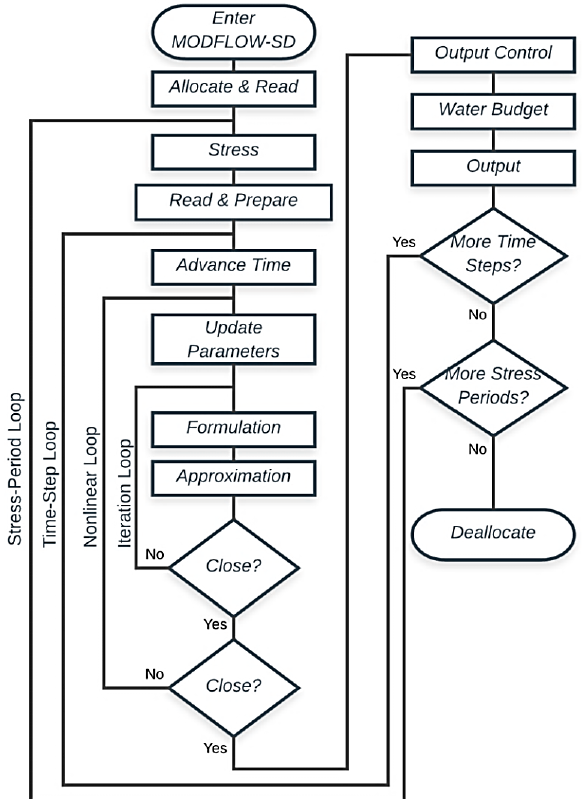
Figure 2. MODFLOW-SD (modified USGS Modular Three-Dimensional Groundwater Flow Model) flowchart to simulate stress-dependent ground-water flow (modified from [33]).